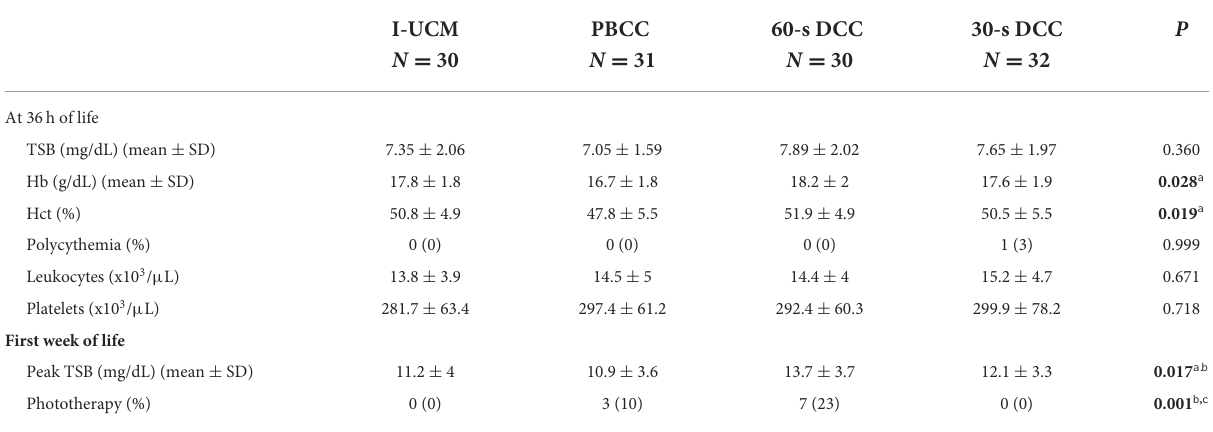
TABLE 3 The infants’ postnatal laboratory